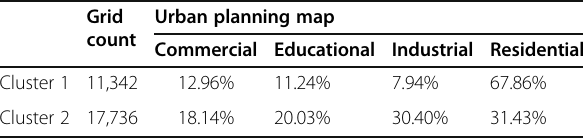
Table 4 The overlap rate between cluster results and urban planning map Grid Urban planning count